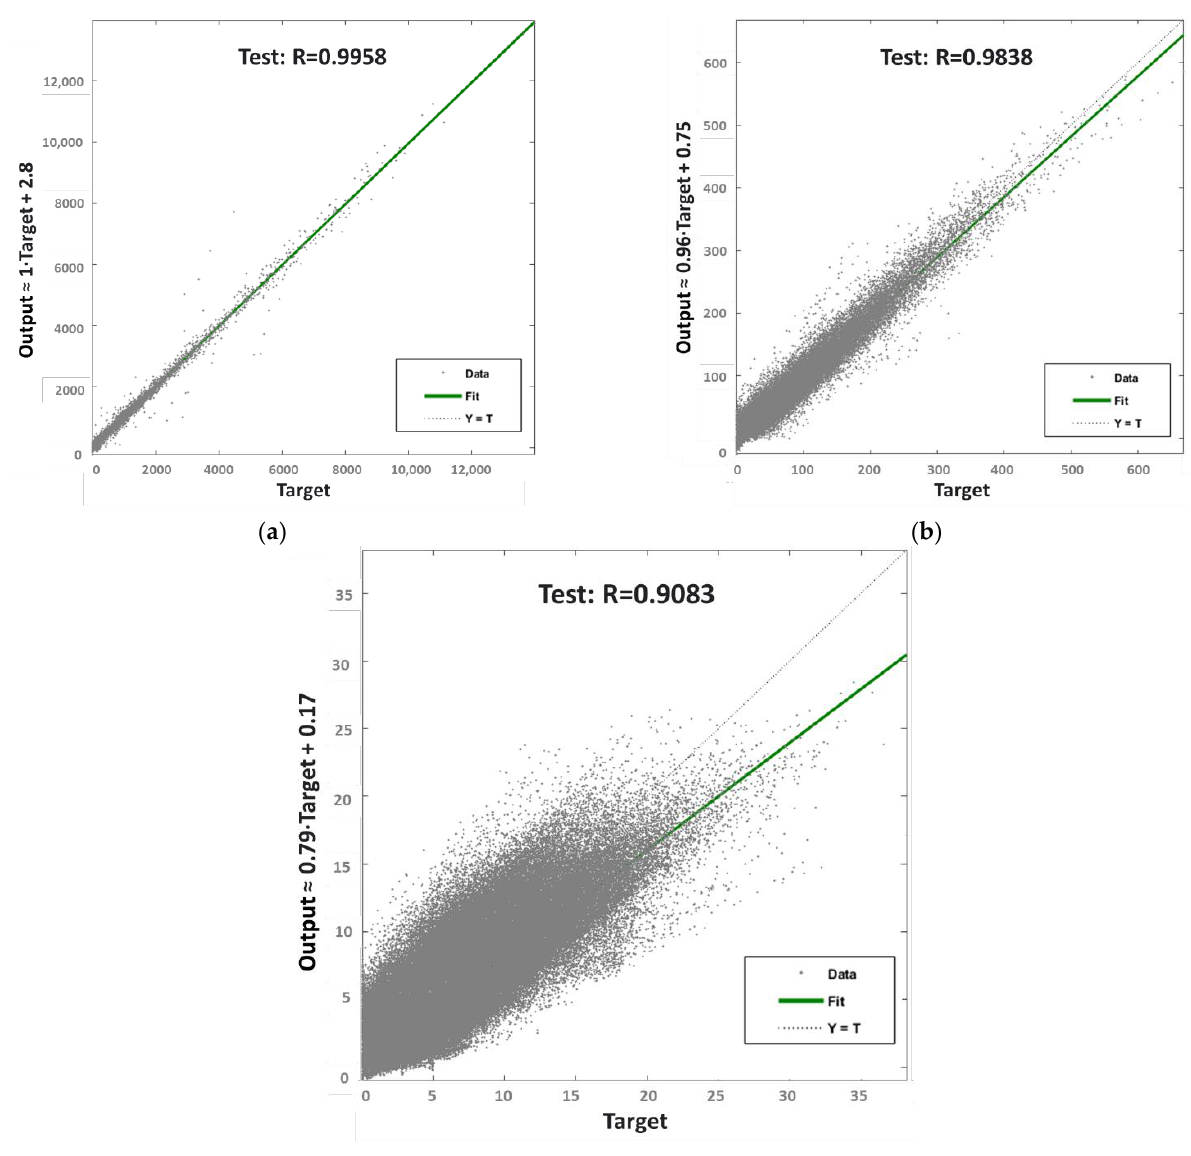
Figure 4. Regression plots for the test data of the ANN analysis for different calculation periods: ( a ) hourly, ( b ) daily and ( c ) monthly.